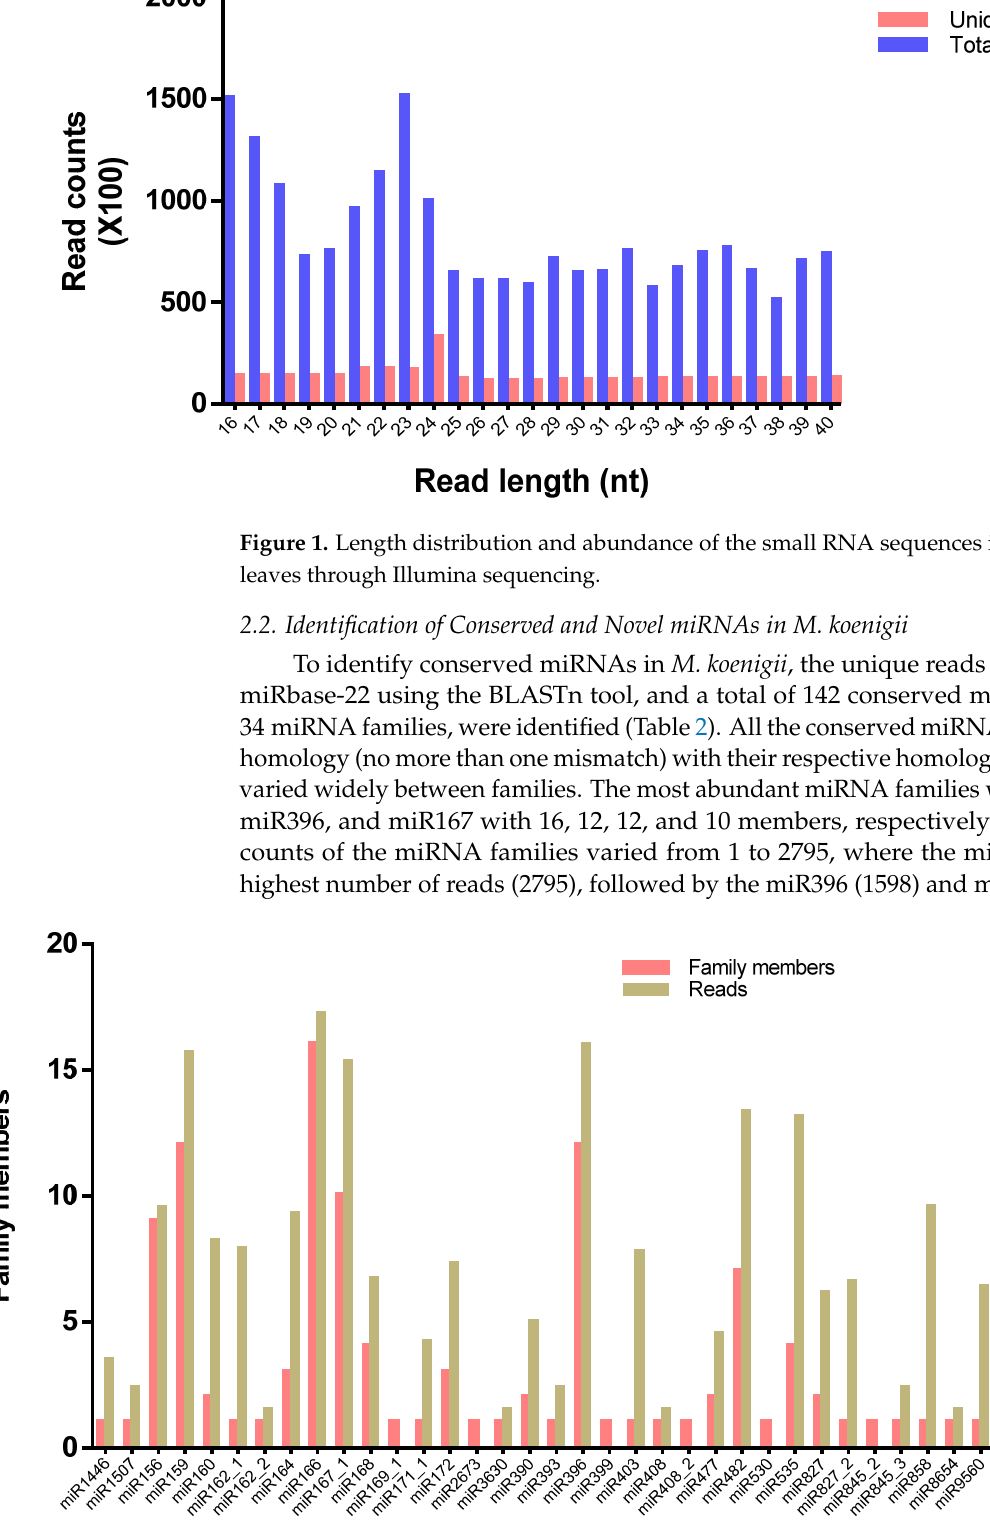
Figure 2. Family members and their respective reads within each miRNA family of M. koenigii.